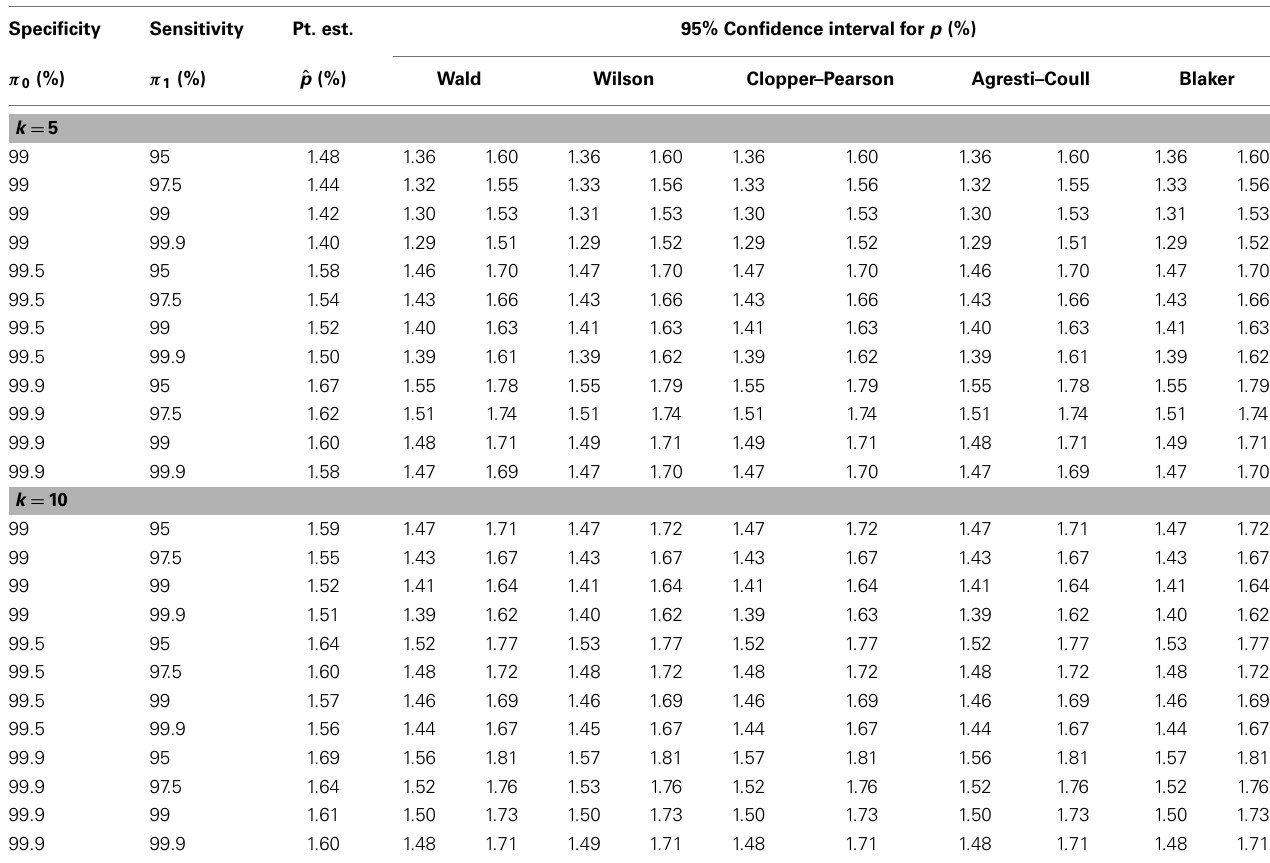
Table 2 |Analysis of HIV seroprevalence data (see Section 5 for